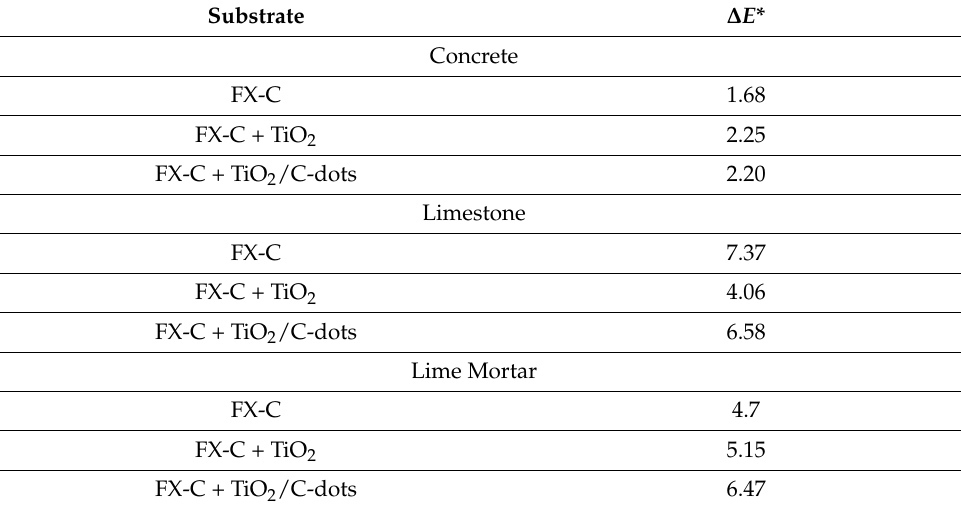
Table 1. Changes in color ( ∆ E *) exhibited by treating different substrates with enhanced photocat- alytic protective